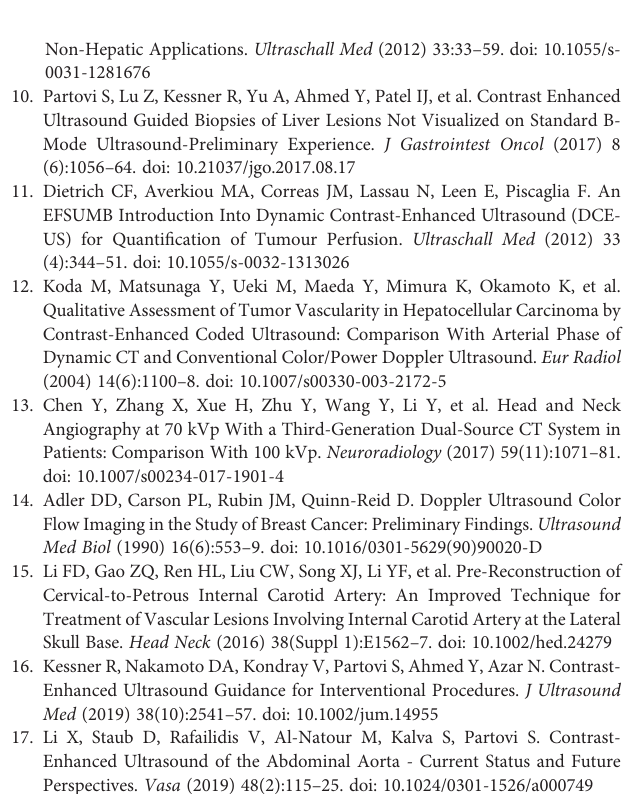
Supplementary Figure 1 | ring-like enhancement observed in a schwannoma lesion. The epineurium (thin arrow) of schwannoma lesion was clearly enhanced during the artery phase and exhibited a ring-like enhancement pattern. Supplementary Figure 2 | TIC analysis of schwannoma lesions. Schwannomas showed a slow wash-in, fast wash-out and low peak intensity pattern in TIC